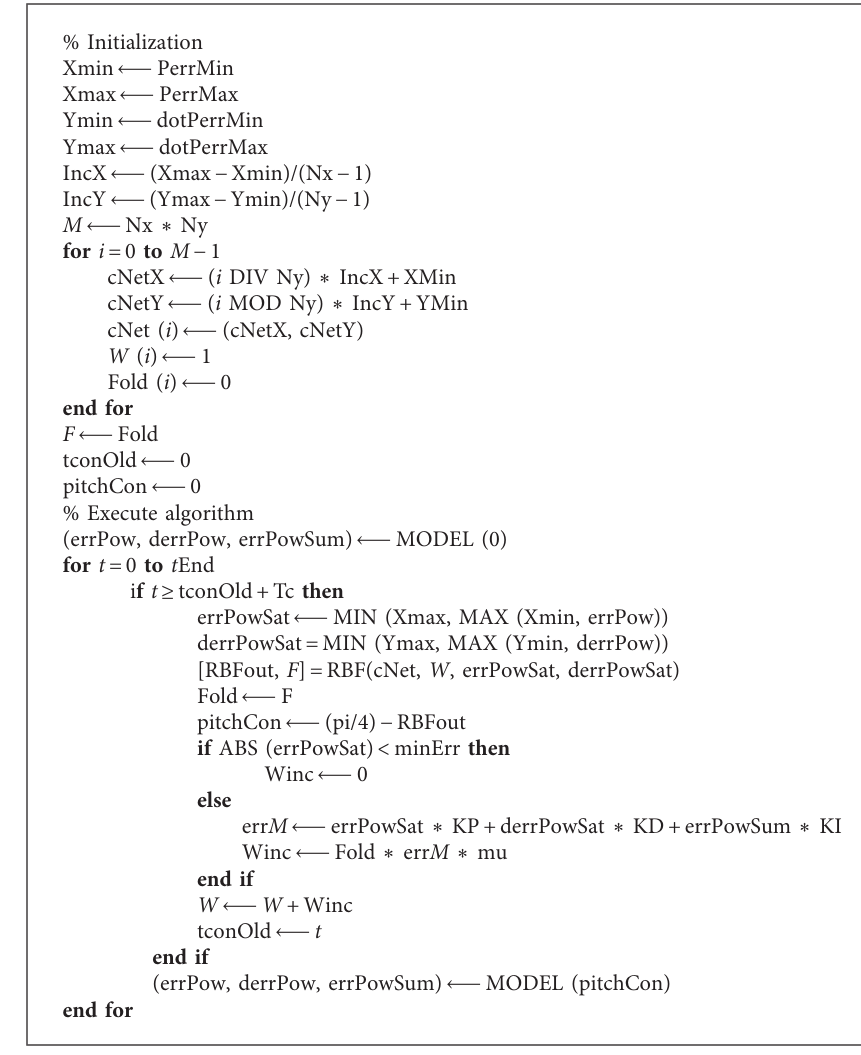
A LGORITHM 1: Proposed learning